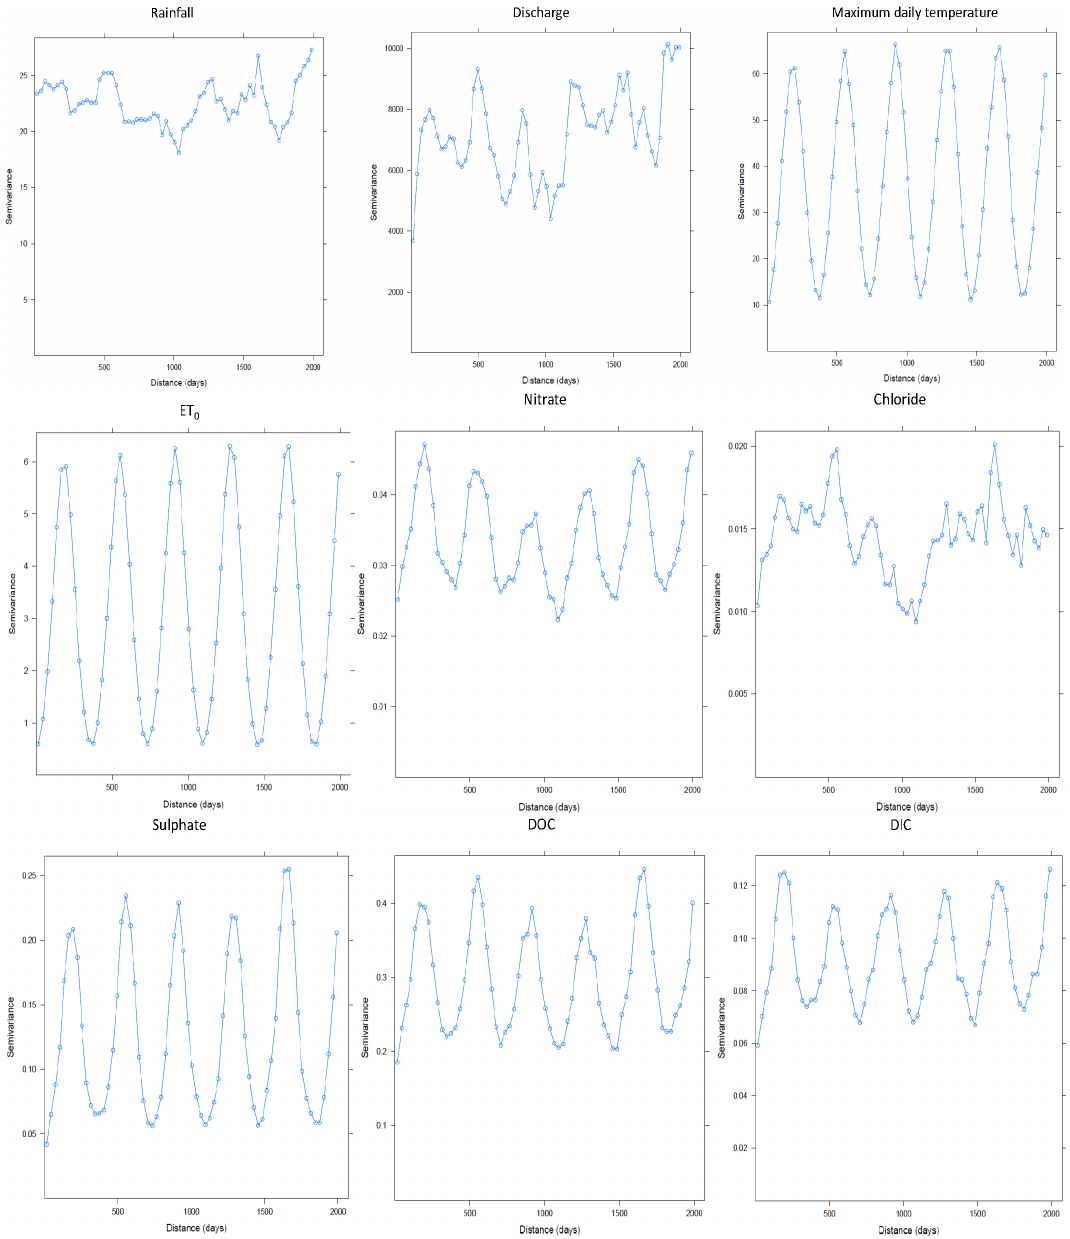
Fig. 4. Temporal variograms of hydro-climatic parameters and daily in-stream solute concentrations built for 2000 days with a 30day lag.